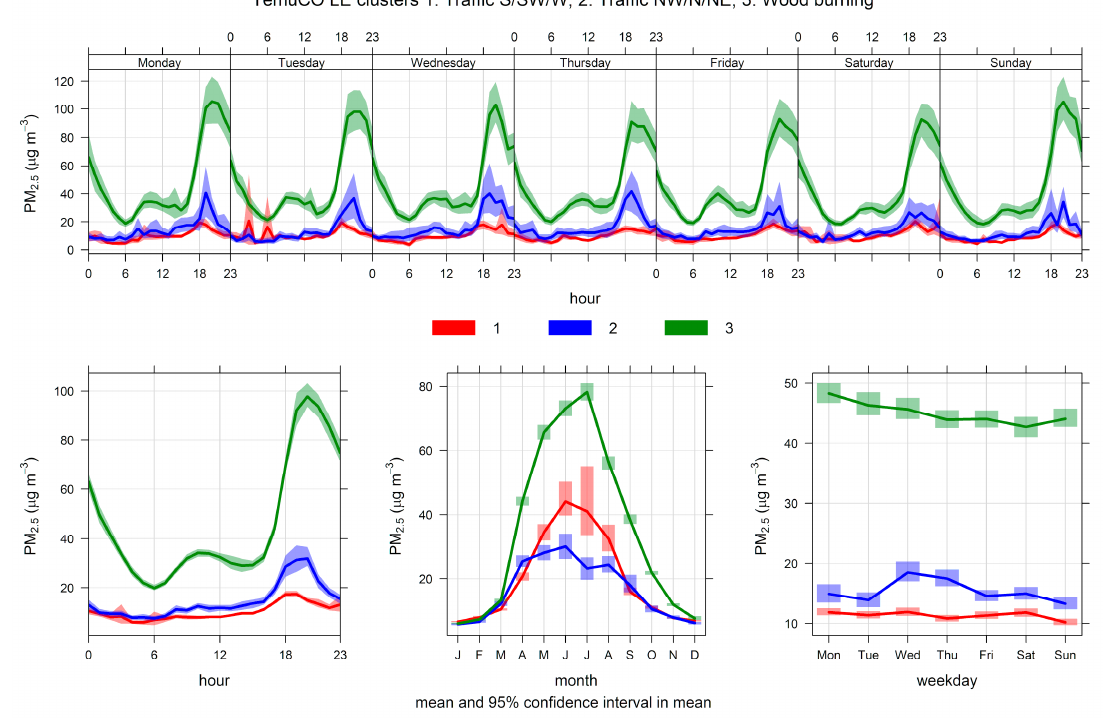
Figure 9. Time variation plot for cluster analysis source apportionment results for ambient PM 2.5 at Temuco, 2009/01–2020/08, for a three-cluster solution.